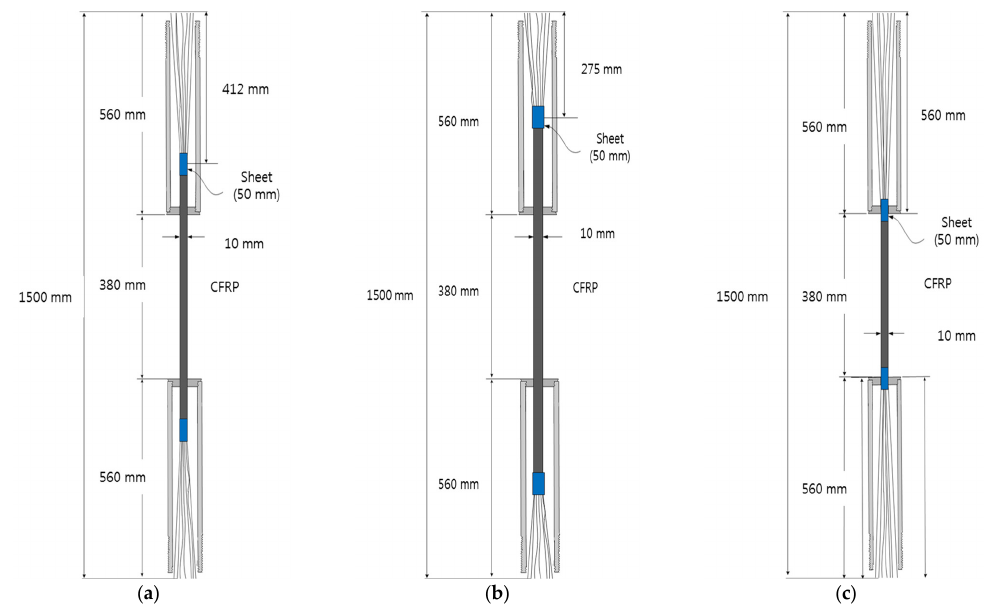
Figure 6. Schematics of sample specimens with respect to the depth of specimen splitting: Cases ( a ) 1, ( b ) 2, and ( c ) 3.